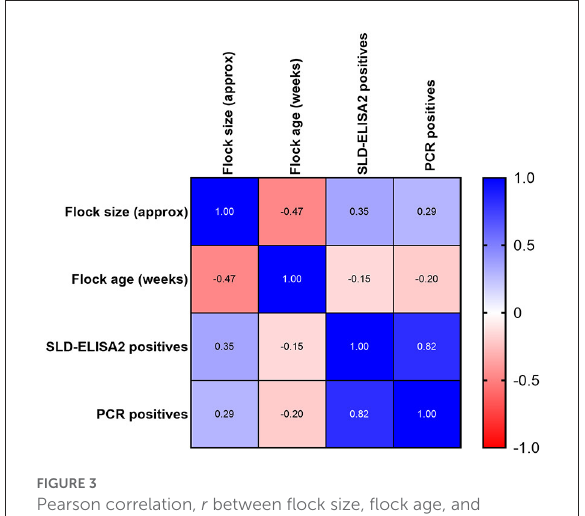
FIGURE3 Pearson correlation, r between flock size, flock age, and percentage of birds positive to SLD-ELISA2 and